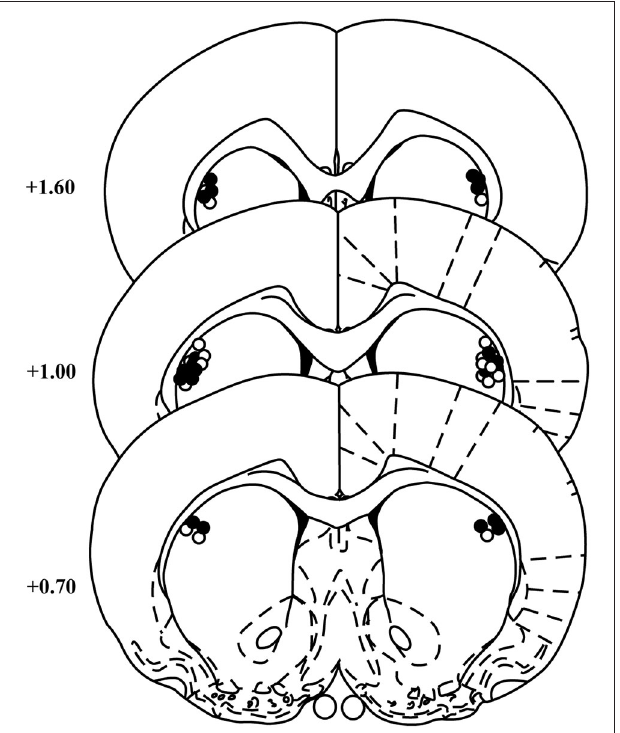
FIGURE 1 | Cannula placements within the DLS . Schematic representation of cannulae placements in the DLS for animals included in the NBQX (open circles) and raclopride (black circles) experiments (templates adapted from Paxinos and Watson, 1998). Numbers indicate the distance from bregma in anterior–posterior plane. N = 11 and 12 for NBQX and raclopride experiments,